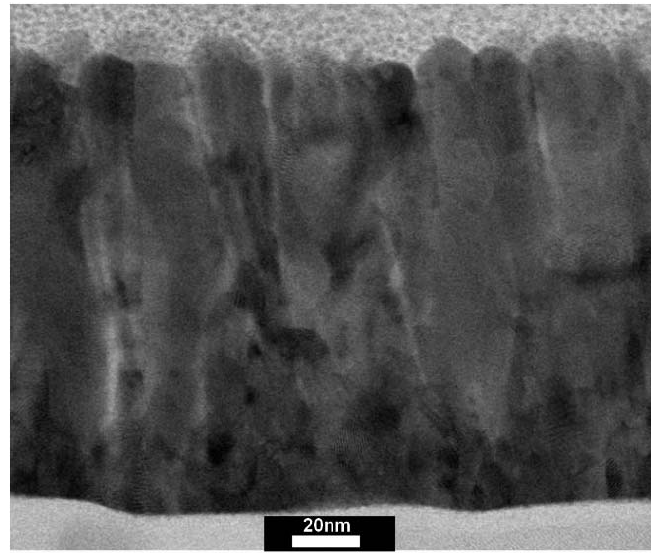
Figure 5. STEM image of the sample with 160 nm Pt film produced by Pt target sputtering using pulsed regime (frequency 100 kHz). Scale bar 20 nm.